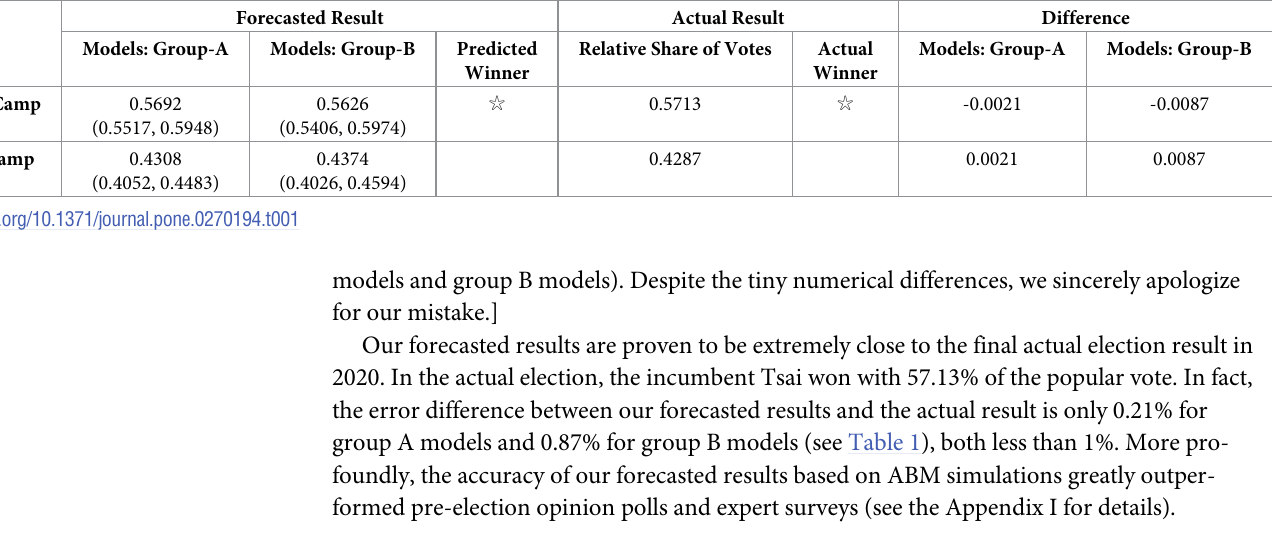
Table 1. Forecasted versus actual result in the 2020 Taiwan general